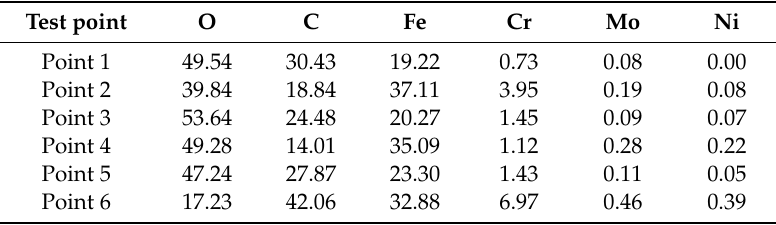
Table 4. EDS results of the wear characteristics (Atomic Percentage).